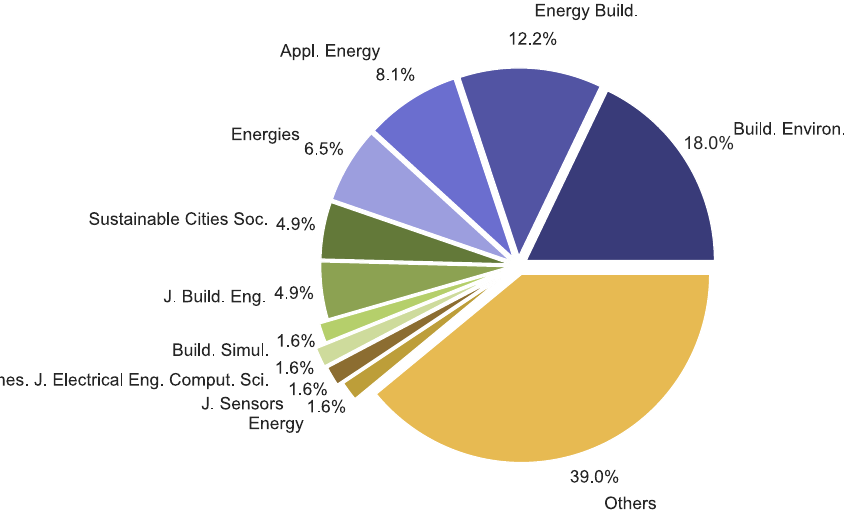
Figure 4. Breakdown of investigated articles by journal.